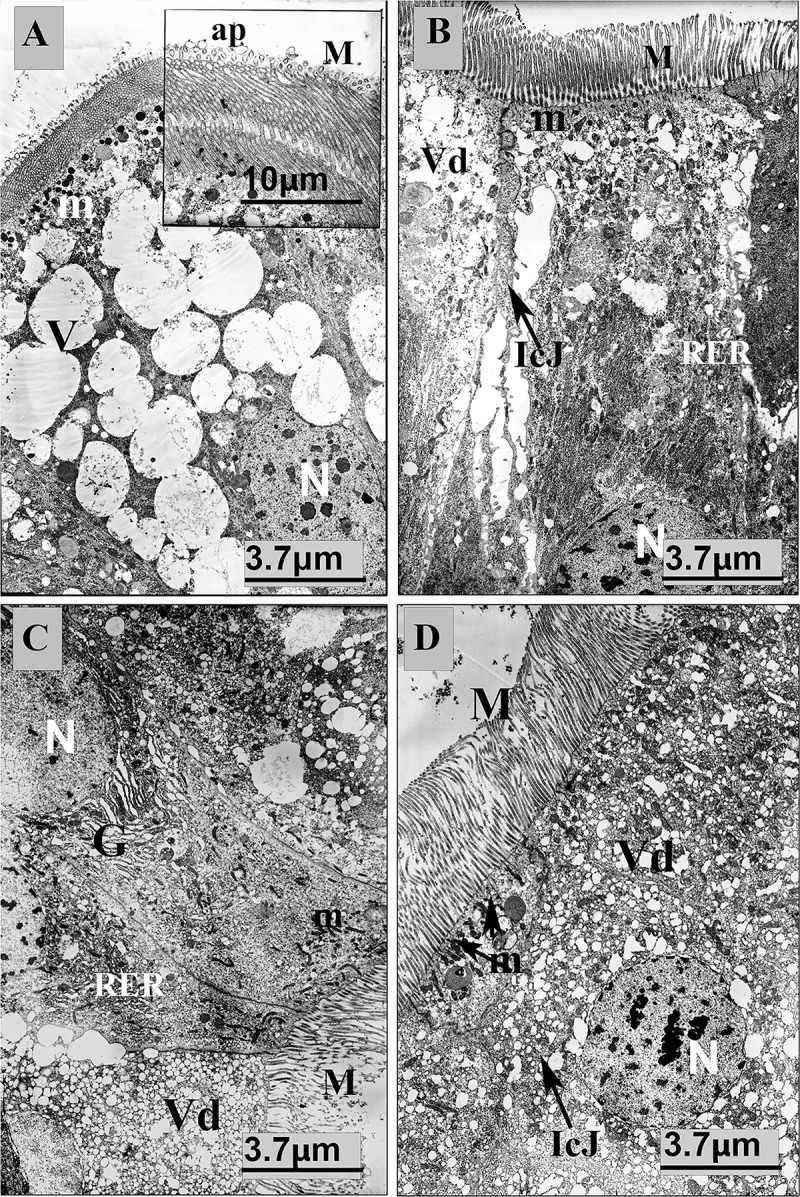
Ultrathin sections of the IV-instar CPB larvae midgut at 48 h posttreatment with B. thuringiensis (Bt) (3 × 107 spores/mL), avermectins (1.125 μg/L) and their combination.(A) Control samples; (B) Treatment with Bt; (C) Treatment with avermectins; (D) Combined treatment (Bt+avermectins). M–microvilli; ap–apocrine bubbles; m–mitochondria; N–nucleus; V–vesicles; RER–rough endoplasmic reticulum; IcJ–intercellular junctions; Vd–vacuolization; G–Golgi apparatus.